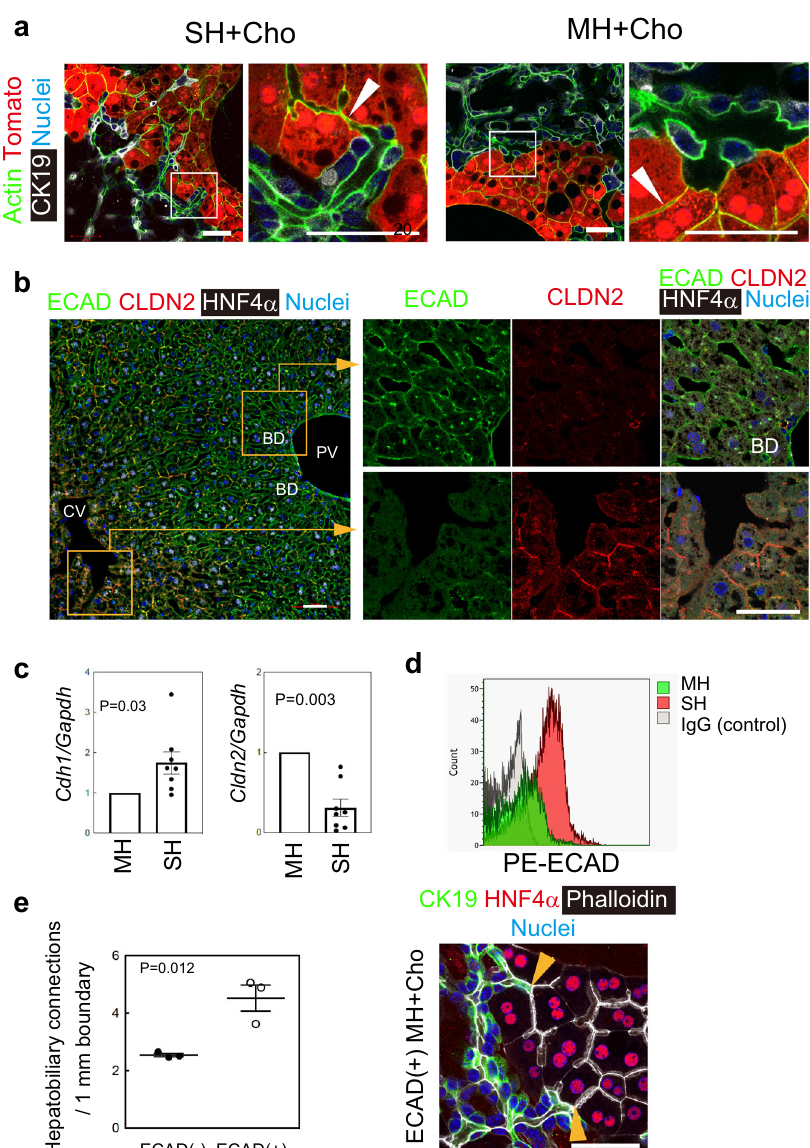
Fig. 5 ECAD + hepatocytes form hepatobiliary junctions with cholangiocytes. a . SHs, but not MHs, ef fi ciently form hepatobiliary connections with cholangiocytes at their boundaries. Both SHs and MHs form BCs (arrowheads) in coculture with cholangiocytes (Cho). However, the BCs of tdTomato + SHs connect to CK19 + BD, whereas BCs of MHs do not connect to BD. The immunostaining with phalloidin (green), anti-CK19 antibody (white), and Hoechst 33342 (blue) was repeated three times independently. Three fi elds were examined in each sample and the representative images are shown in this fi gure. Boxes in left-side panels of SH + Cho and MH + Cho are enlarged in the right-side panels, respectively. Bars represent 50 μ m. b . ECAD is expressed in ZONE1&2 and CLDN2 in ZONE3 hepatocytes in the adult liver. Hepatocytes in ZONE1&2 near the PV are ECAD + CLDN2 − (upper right panels), whereas those in ZONE3 near the CV are ECAD − CLDN2 + (lower right panels). An adult liver section was stained with anti-ECAD (green), anti- CLDN2 (red), and anti-HNF4 α (white) antibodies. Nuclei were counterstained with Hoechst 33342 (blue). The immunostaining with anti-ECAD, anti- CLDN2, HNF4 α antibodies, and Hoechst 33342 was repeated on sections prepared from two different mice. Three fi elds were examined in each section and the representative images are shown in this fi gure. Boxes in the left panel are enlarged in the right panels. Bars represent 50 μ m. c . SHs express more Cdh1 and less Cldn2 than MHs. Cdh1/Ecad is higher in SHs than in MHs. qPCR analysis shows that Cldn2 is expressed at a lower level in SHs than in MHs. MHs and SHs were isolated from the same mouse eight times independently and used for qPCR analysis ( n = 8). Bars represent SEM. Two-tailed paired t -tests were performed to compare gene expression between MHs and SHs. d . ECAD expression patterns are different in SHs and MHs. FACS analysis shows that all SHs are ECAD + , whereas MHs consist of both ECAD − and ECAD + cells. MHs and SHs were incubated with PE-conjugated anti-ECAD antibody, and ECAD expression was examined using a FACSAria equipped with a green laser. The FACS plot is representative of two independent analyses. The gating for analysis of ECAD expression in SHs and MHs is shown in Supplementary Fig. 16. e . ECAD + MHs form hepatobiliary junctions. ECAD + MHs form hepatobiliary junctions with cholangiocytes more ef fi ciently than ECAD − MHs. Co-culture and immunostaining with anti-CK19 antibody (green), anti- HNF4 α antibody (red), phalloidin (white), and Hoechst 33342 (blue) were repeated three times ( n = 3). Each dot in the graph represents the average value of hepatobiliary connections counted in three to four areas in each culture sample. Unpaired two-tailed t -tests were performed using Microsoft Excel. Bars represent SEM. The right panel shows the representative image of three independent experiments. Scale bar represents 50 μ